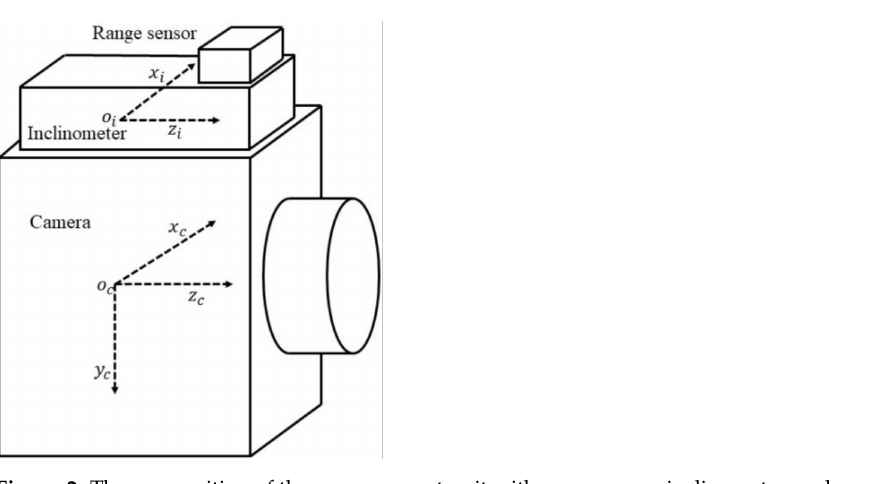
Figure 2. The composition of the measurement unit with a camera, an inclinometer, and a range sensor. Feng et al. used an inertial measurement unit (IMU) which was fixed on the camera to obtain the relative angles to aid camera calibration [23]. However, since the acceleration and attitude angle obtained through the IMU are based on the inertial reference system, the angle output is deviated from the influence of the earth’s rotation and the magnetic field. In order to eliminate this influence, the attitude angle is obtained with a differential algorithm to improve the accuracy, which leads to additional operations in stereo camera calibration. In this study, the inclinometer, which is based on the “physical pendulum” structure, is adopted to directly output the pitch and roll angles relative to the horizontal plane without any